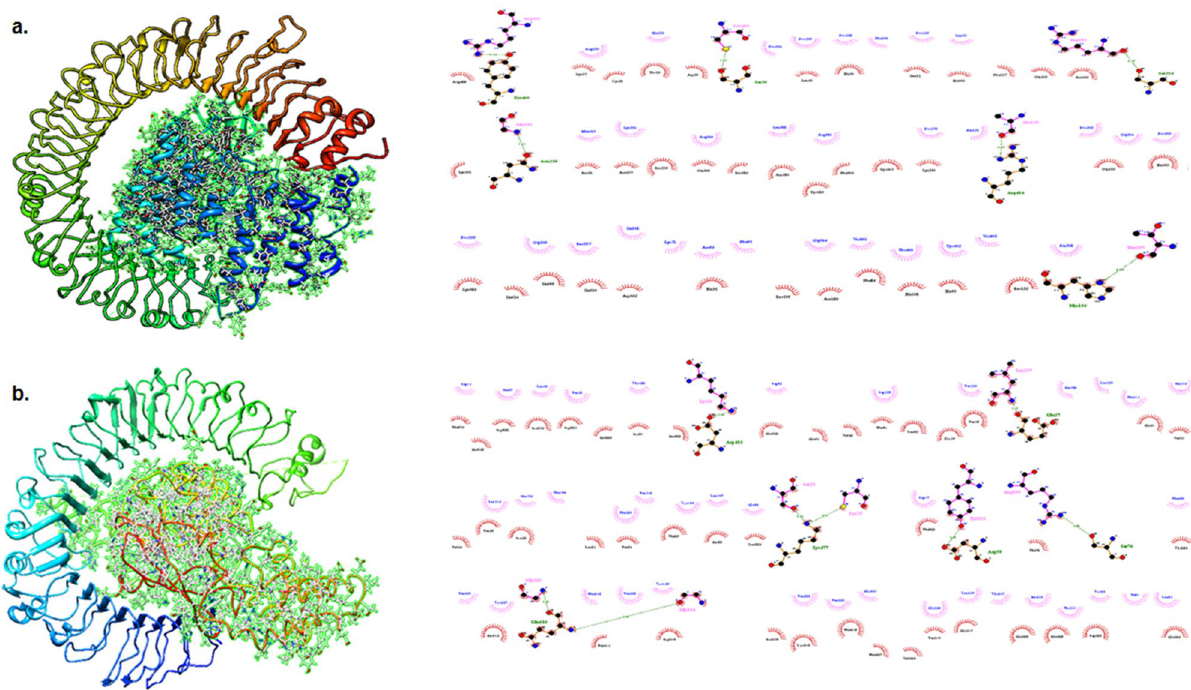
Figure 4. Molecular docking between multi-epitope chimeric vaccine construct and TLR 3 & TLR 4 receptors using the PatchDock (https:// bioin fo3d. cs. tau. ac. il/ Patch Dock/ php. php) server, ( a ). Depiction of the docked conformation and interaction of the TLR 3 & multi-epitope chimeric vaccine construct in Ligplot analysis indicating hydrogen bonding and hydrophobic interactions between the construct and TLR3, ( b ). Depiction of the docked conformation and interaction of the TLR 4 & multi-epitope chimeric vaccine construct in Ligplot analysis indicating hydrogen bonding and hydrophobic interactions between the construct and TLR4.